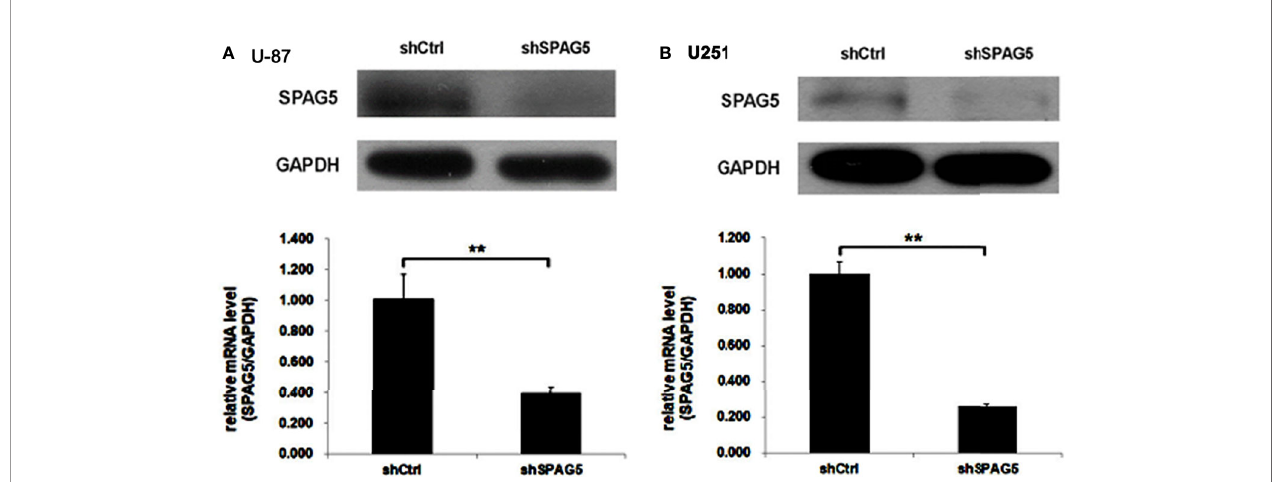
FIGURE 2 | The expression of sperm-associated antigen 5 (SPAG5) in (A) U-87 and (B) U251 cells transfected with SPAG5-shRNA was measured by Western blotting and qRT-PCR, respectively. Results were expressed as mean ± SD from three independent experiments. ** P < 0.01.